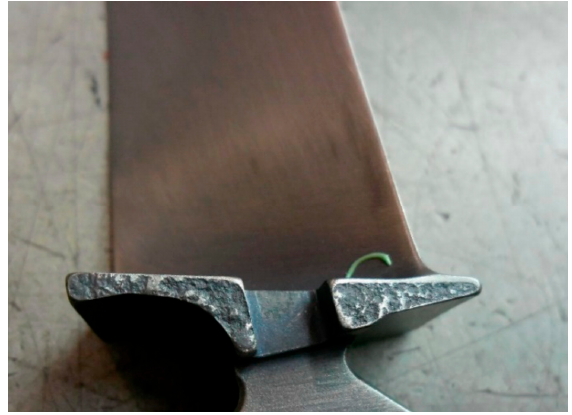
Figure 5. Effect of the abrasion mechanism on a HPC blade [52].